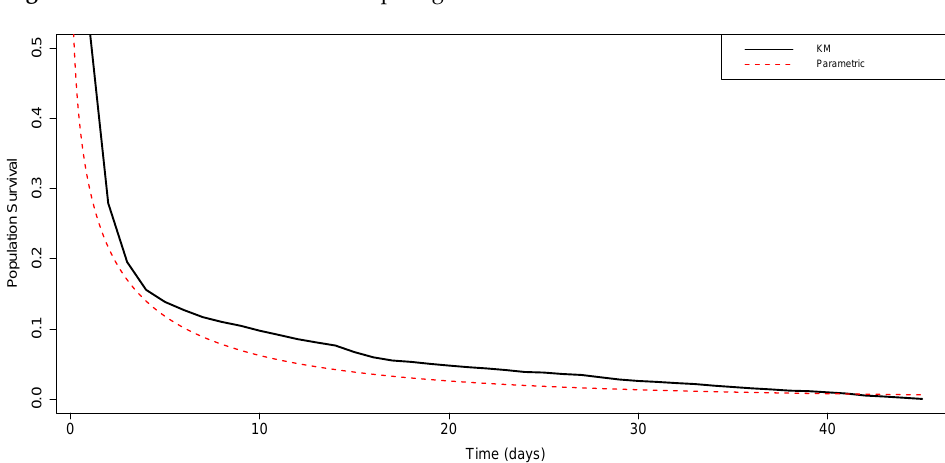
Figure 6. Estimated HRFs for the competing baseline hazards.